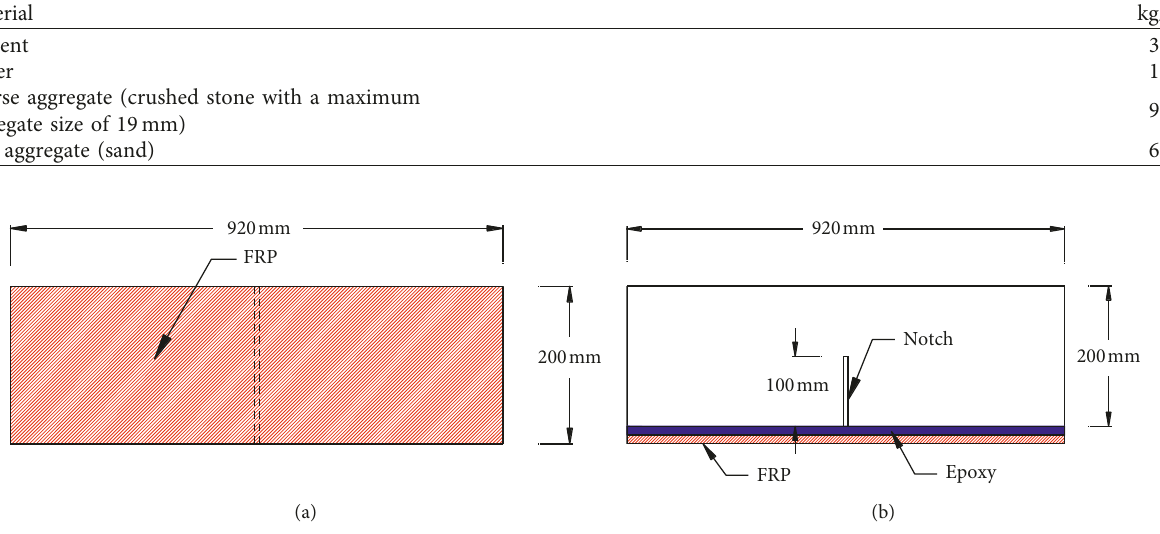
Table 1: Concrete mix design.